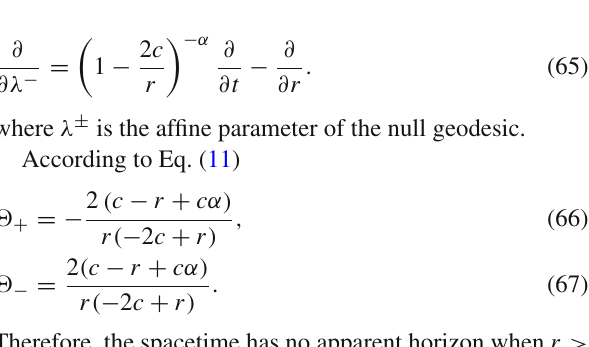
Fig. 4 Penrose diagram for the HMN scalar field ( a (cid:4)= 0 , c (cid:4)= 0) matching with two outgoing Vaidya spacetimes. We see that the naked singularity in Fig. 3 has been replaced by the Vaidya